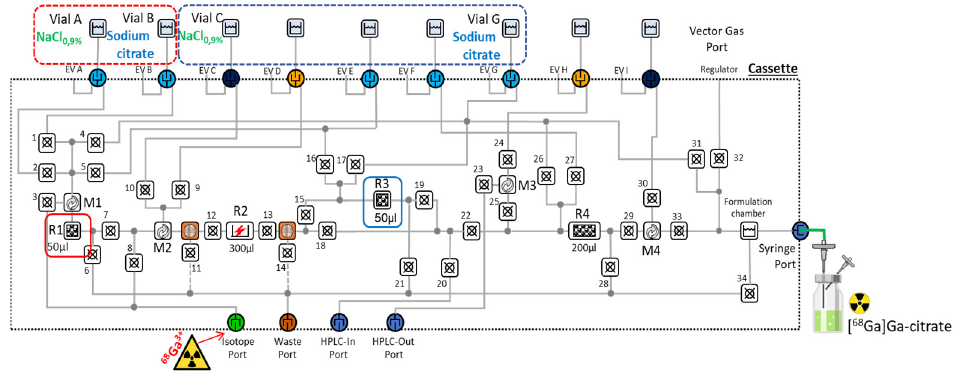
Figure 3. Schematic representation of iMiDEV™ microfluidic cassette used for [ 68 Ga]Ga-citrate pro- duction; highlighted in red—single synthesis on R1 with Vials A and B; highlighted in blue—single synthesis on R3 with vials C and G.